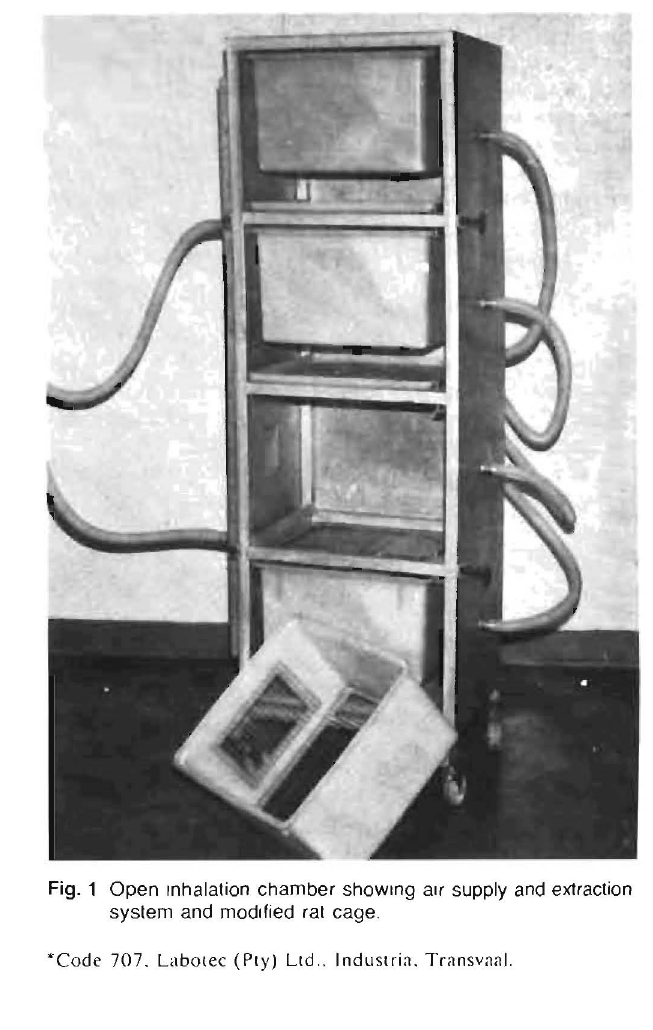
Fig. 1 Open Inhalation chamber shOWing air supply and extraction system and modified rat